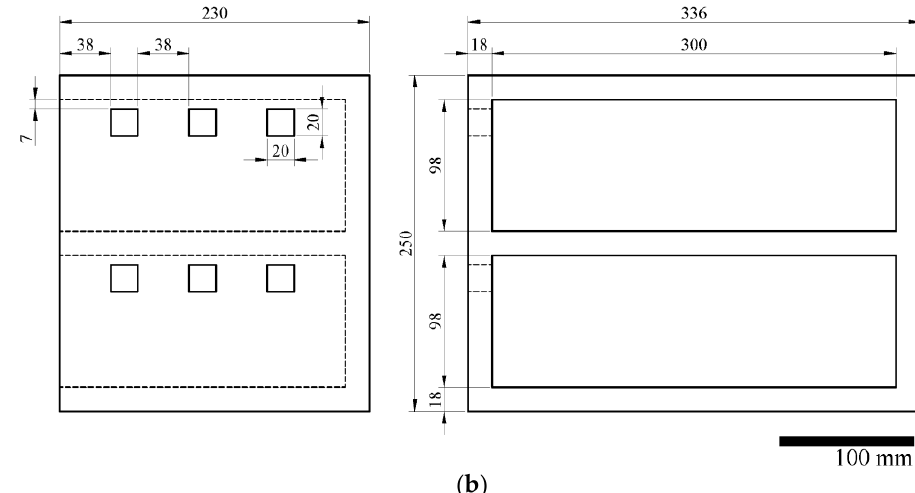
Figure 13. Model house used to confirm lighting performance: ( a ) Overall appearance of the model house. Here, sunlight guiding panel was not used in the first-floor room and was used in the second-floor room, and ( b ) floor plan of the model house.